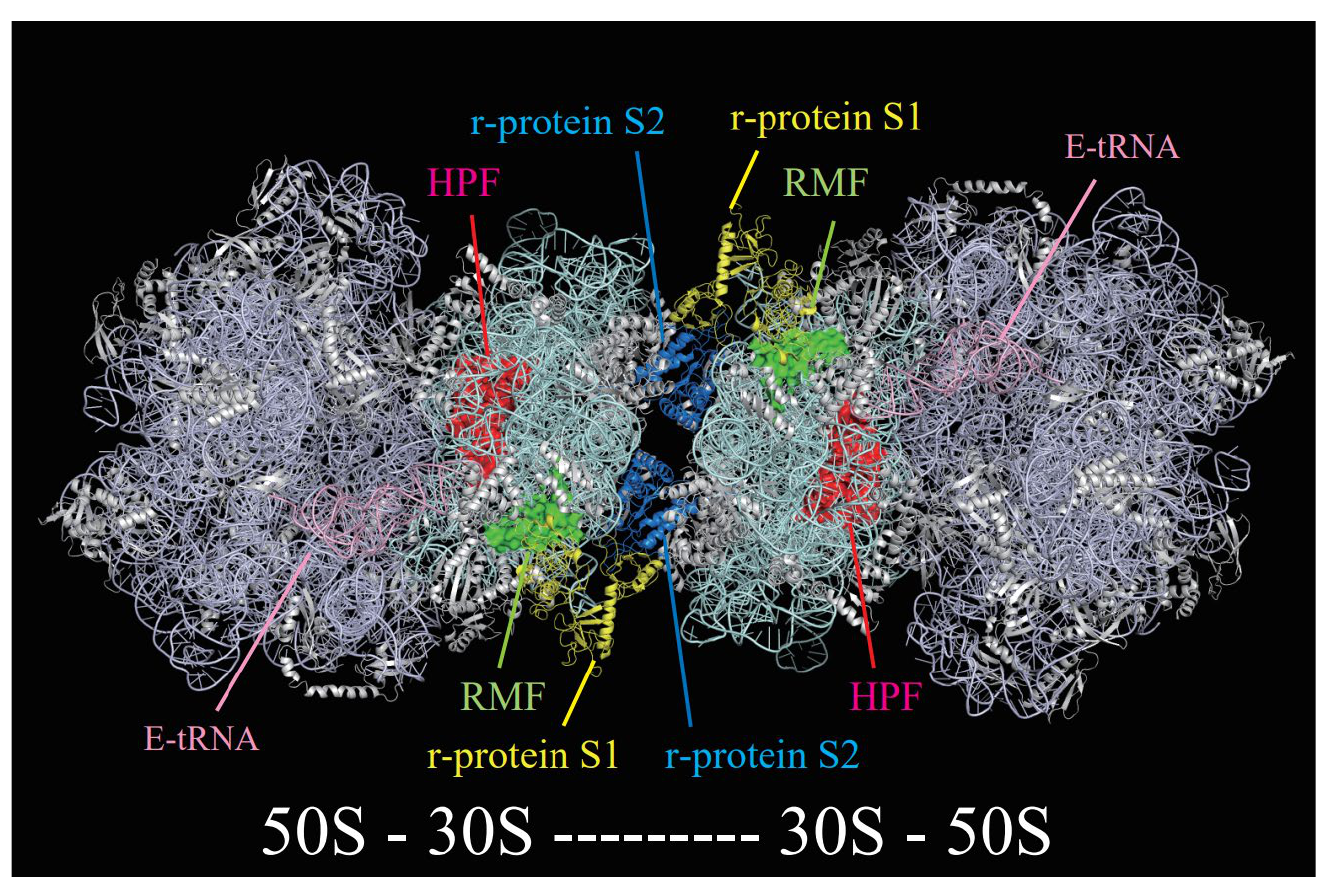
Figure 1. Structure of the 100S ribosome in Escherichia coli (PDB ID: 6H58). The 100S ribosome is formed by 30S subunits of the two 70S ribosomes (50S-30S-30S-50S). RMF, the key factor for ribosome dimerization, is shown in green. HPF, a factor that stabilizes the 100S ribosome, is shown in red. Ribosomal proteins S1 and S2, which play important roles in forming the 100S ribosome, are shown in yellow and blue, respectively. The tRNA of the E site bound to the 100S ribosome is shown in pink.